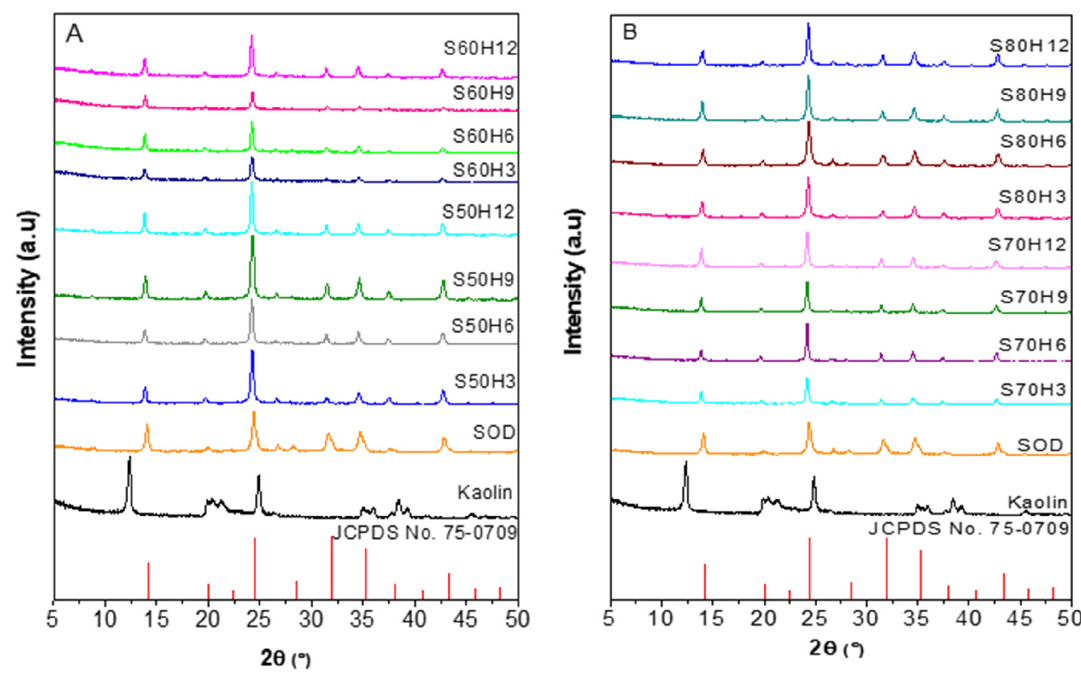
Figure 1. XRD (X-ray diffraction) analysis of samples with various crystallization times and temperatures of ( A ) 50–60 °C, and ( B ) 70–80 °C.